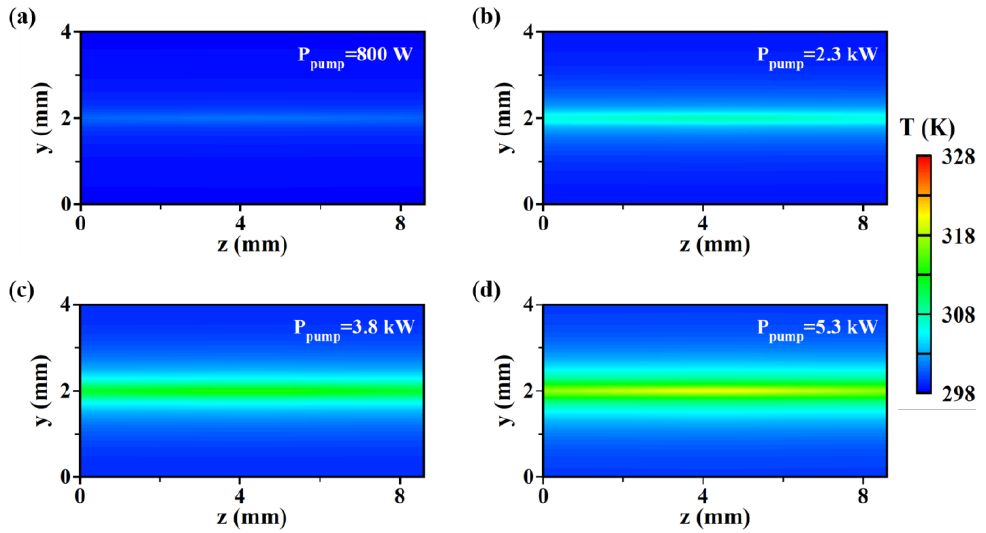
Figure 2. Cross-sectional temperature distribution of diamond crystal at pumping power ( a ) 800 W ( b ) 2.3 kW ( c ) 3.8 kW, and ( d ) 5.3 kW, respectively.